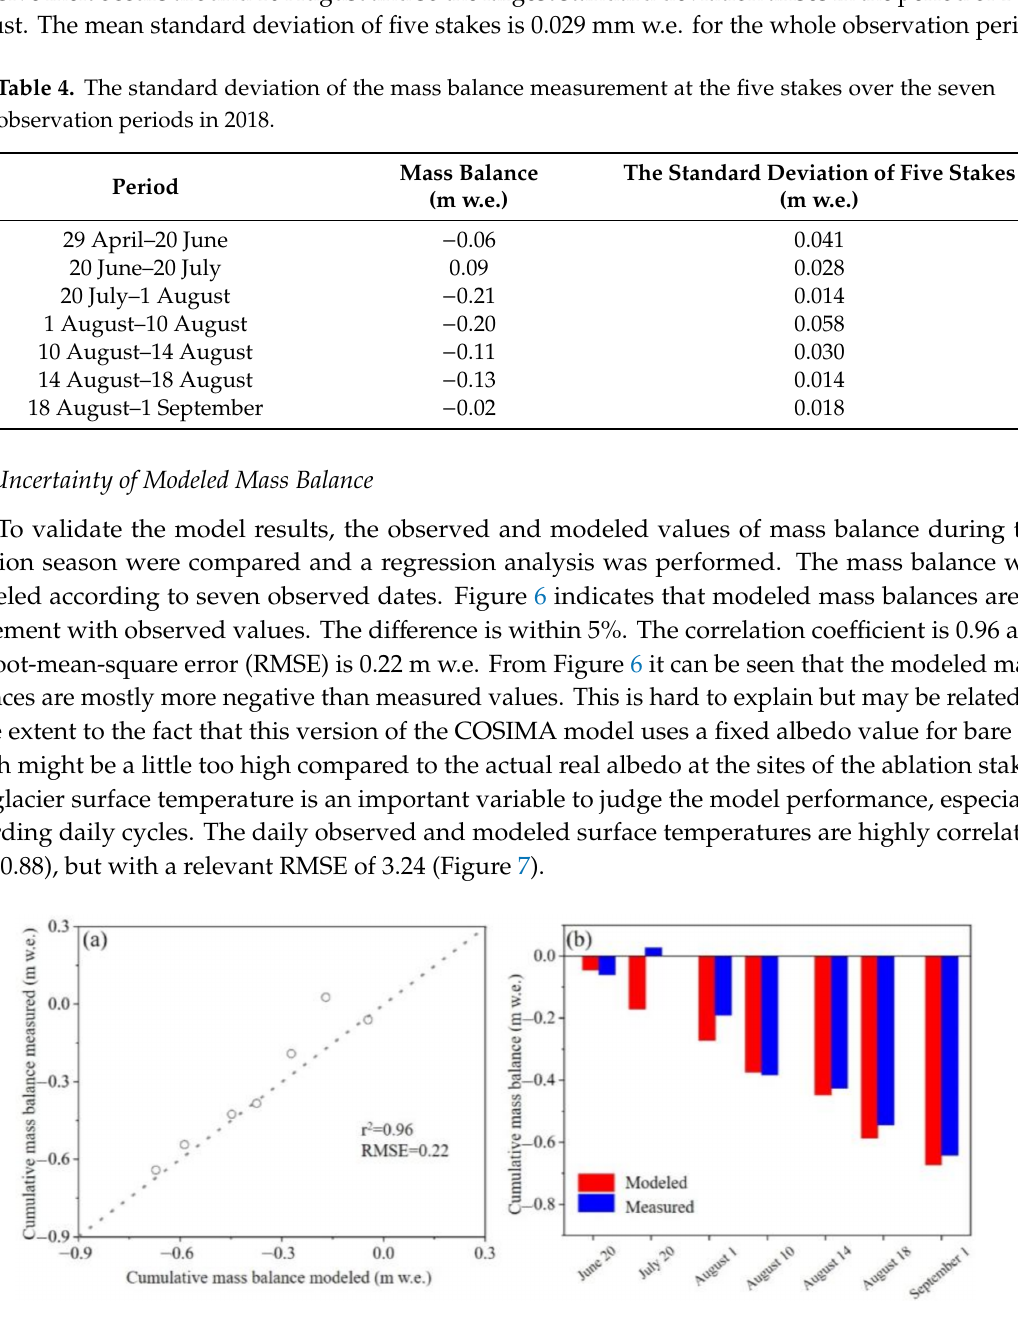
Figure 6. Scatter plot ( a ) and temporal evolution ( b ) of both, the modeled and measured average cumulative mass balance. The grey dashed line is the 1:1